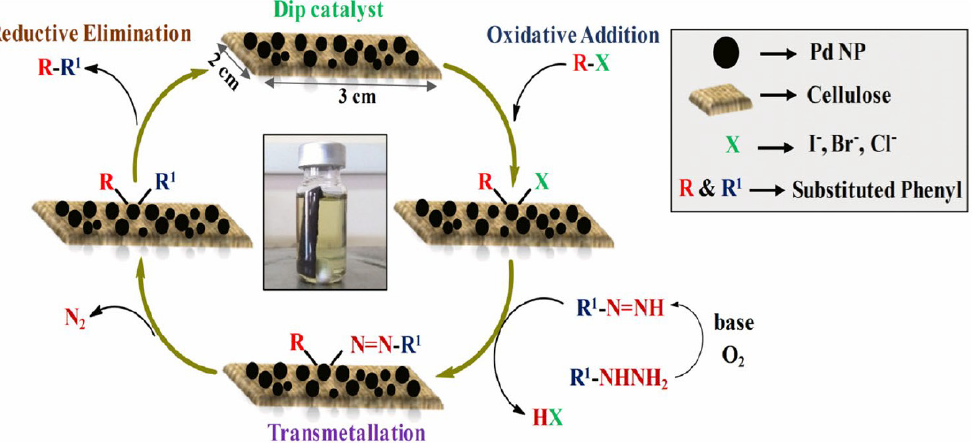
Figure 12. Mechanism proposed by Kempasiddaiah et al. for denitrogenative cross-coupling reac- tions [89].